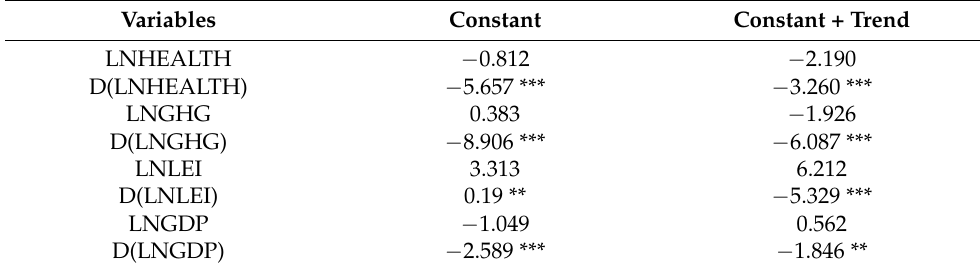
Table 4. CIPS panel unit root test